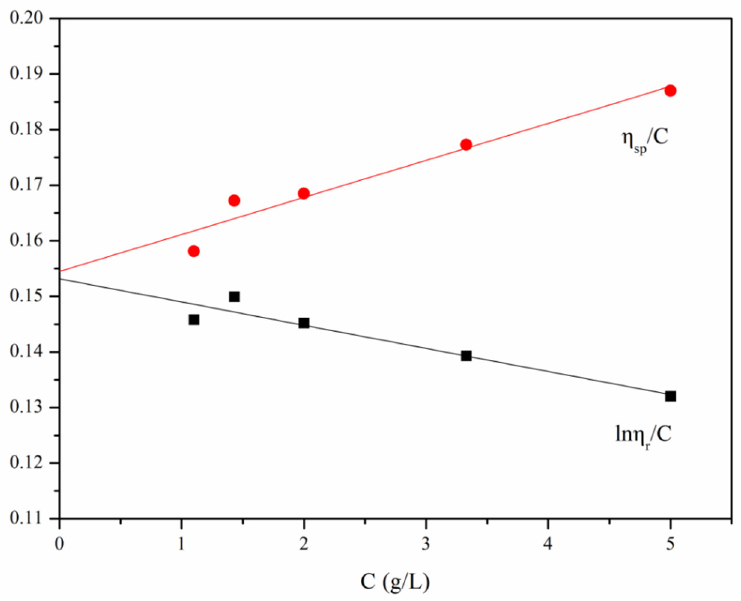
Figure 7. The relationship between C-ln η r /C and C- η sp /C of N-2-HACC. T = 25.15 ± 0.5